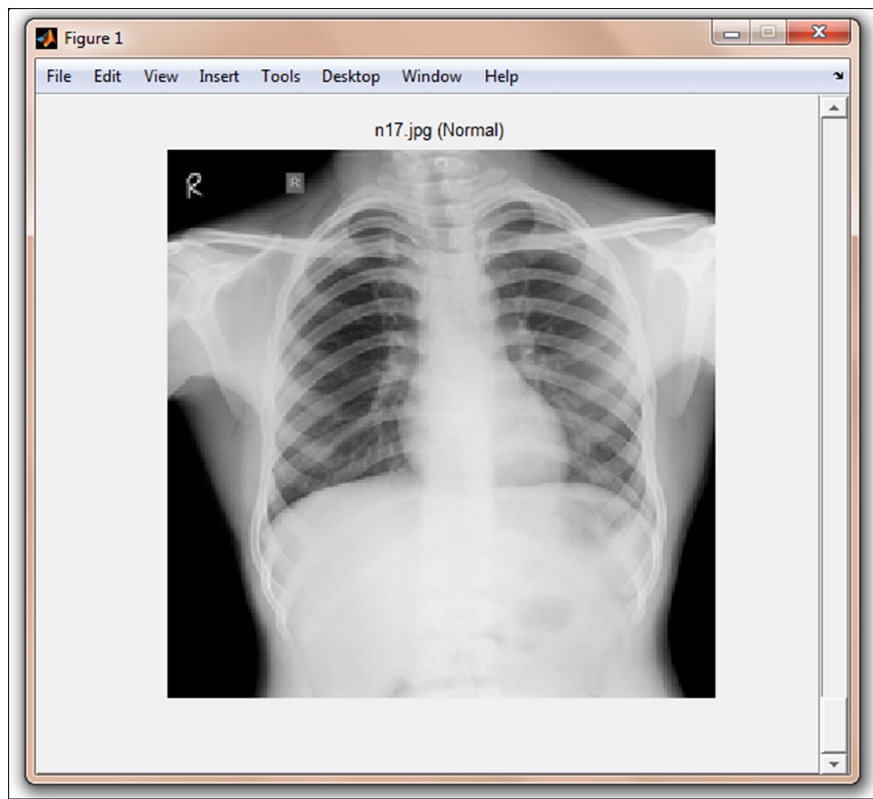
Figure 10. GUI of sample output provided by Matlab toolbox, TB-Xpredict.